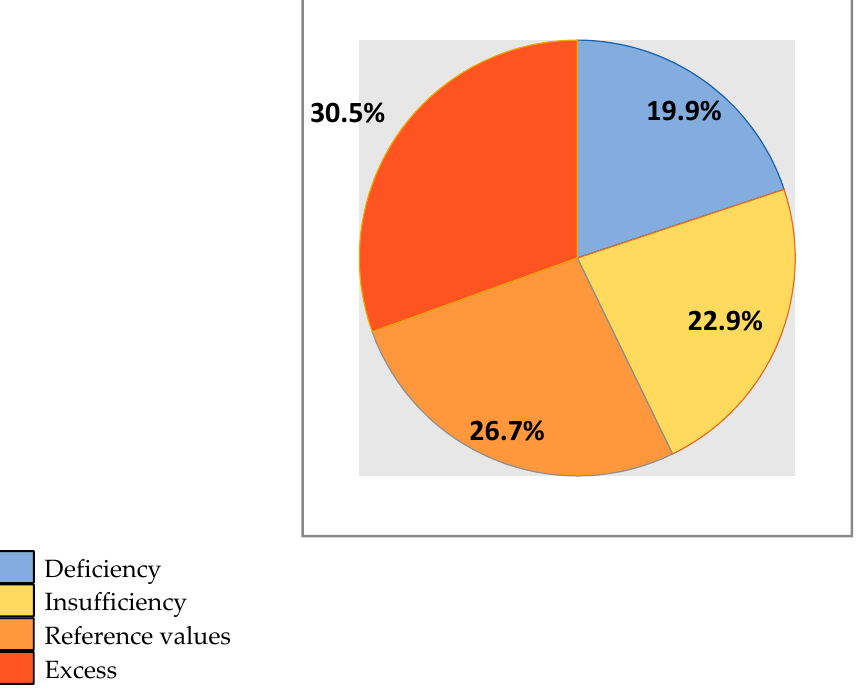
Figure 1. Serum level of vitamin 25-hydroxycalciferol (25(OH)D) in young professional football players permanently residing in Moscow (percentage).